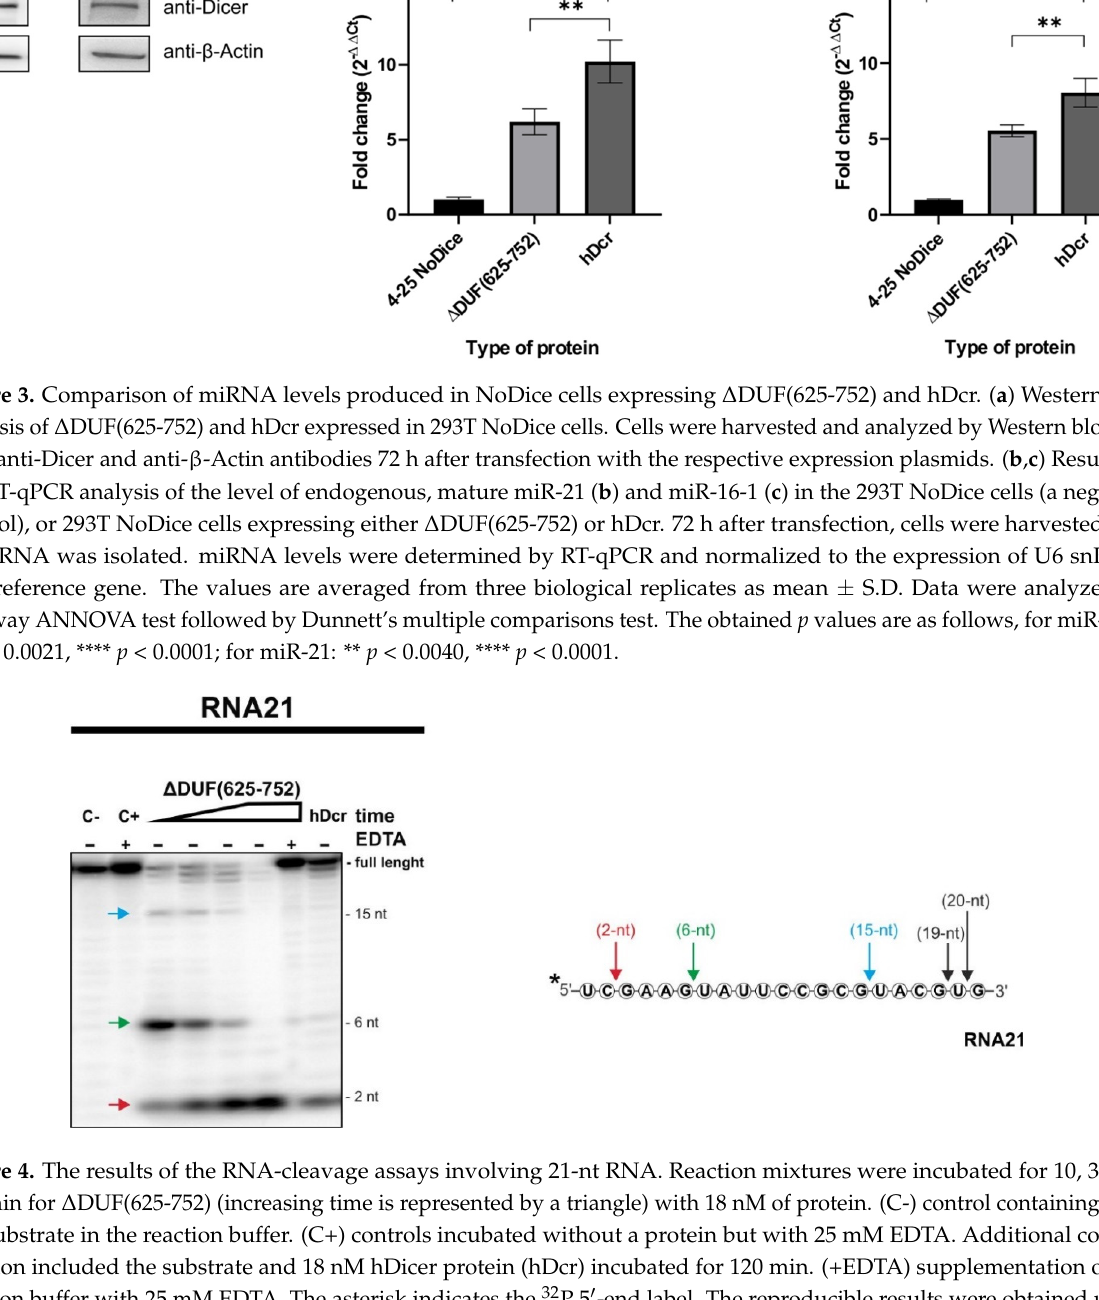
Figure 4. The results of the RNA-cleavage assays involving 21-nt RNA. Reaction mixtures were incubated for 10, 30, 60, 120 min for Δ DUF(625-752) (increasing time is represented by a triangle) with 18 nM of protein. (C-) control containing